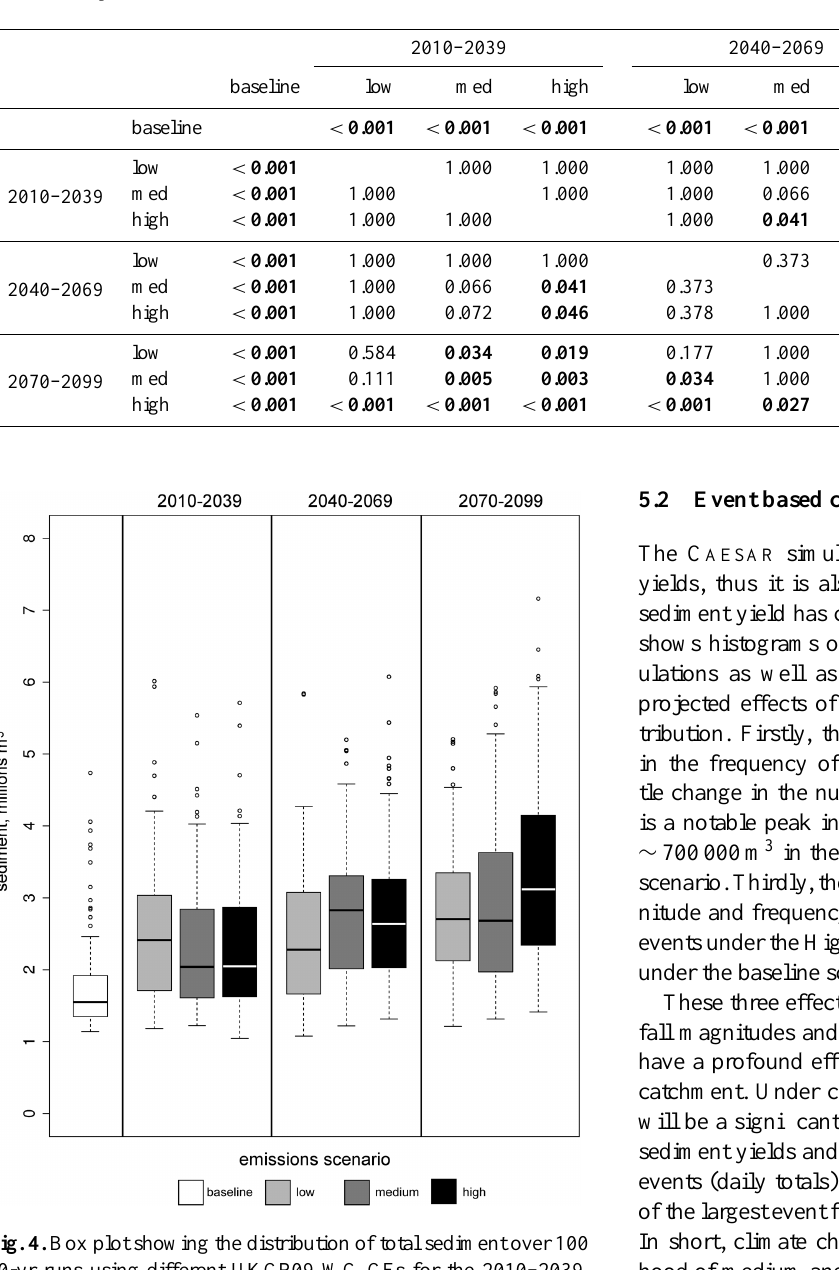
Table 1. Comparison of sediment totals using Student’s t-test, with p-values adjusted for multiple comparisons (Holm, 1979). Significant differences ( p ≤ 0.05) are in bold.